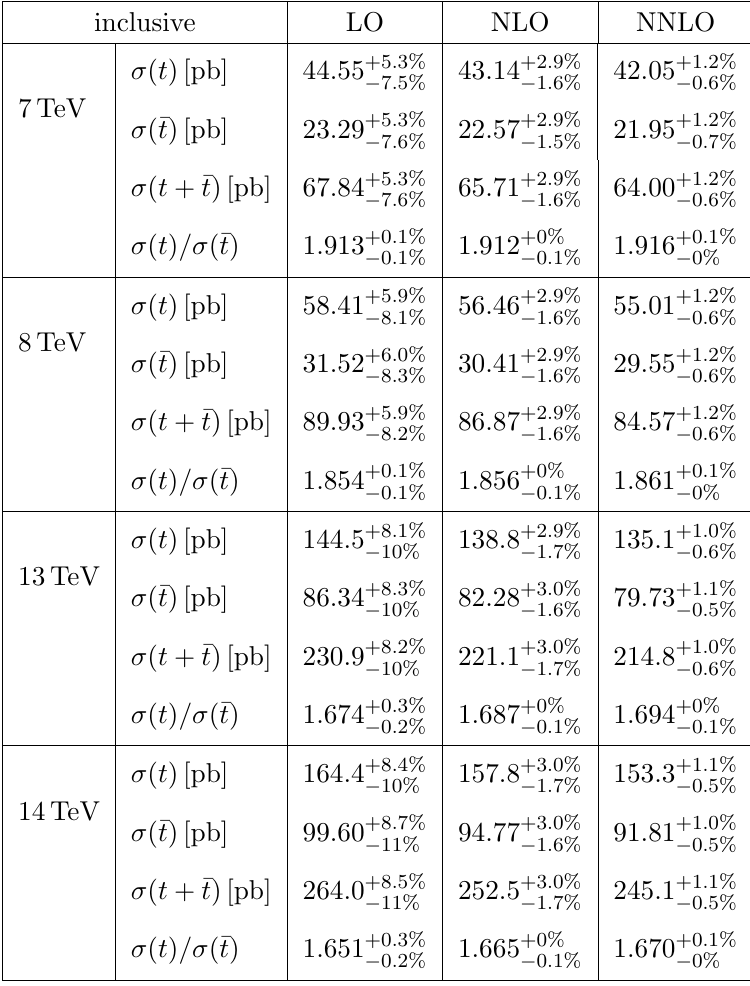
Table 1 . Inclusive cross sections and their ratio for t -channel single top (anti-)quark production at LO, NLO and NNLO with CT14 NNLO PDFs at the LHC with di(cid:11)erent center of mass energies. Scale uncertainties are obtained by varying the renormalization and factorization scale from (cid:22) (cid:22) R = m t = 2 to 2 m t